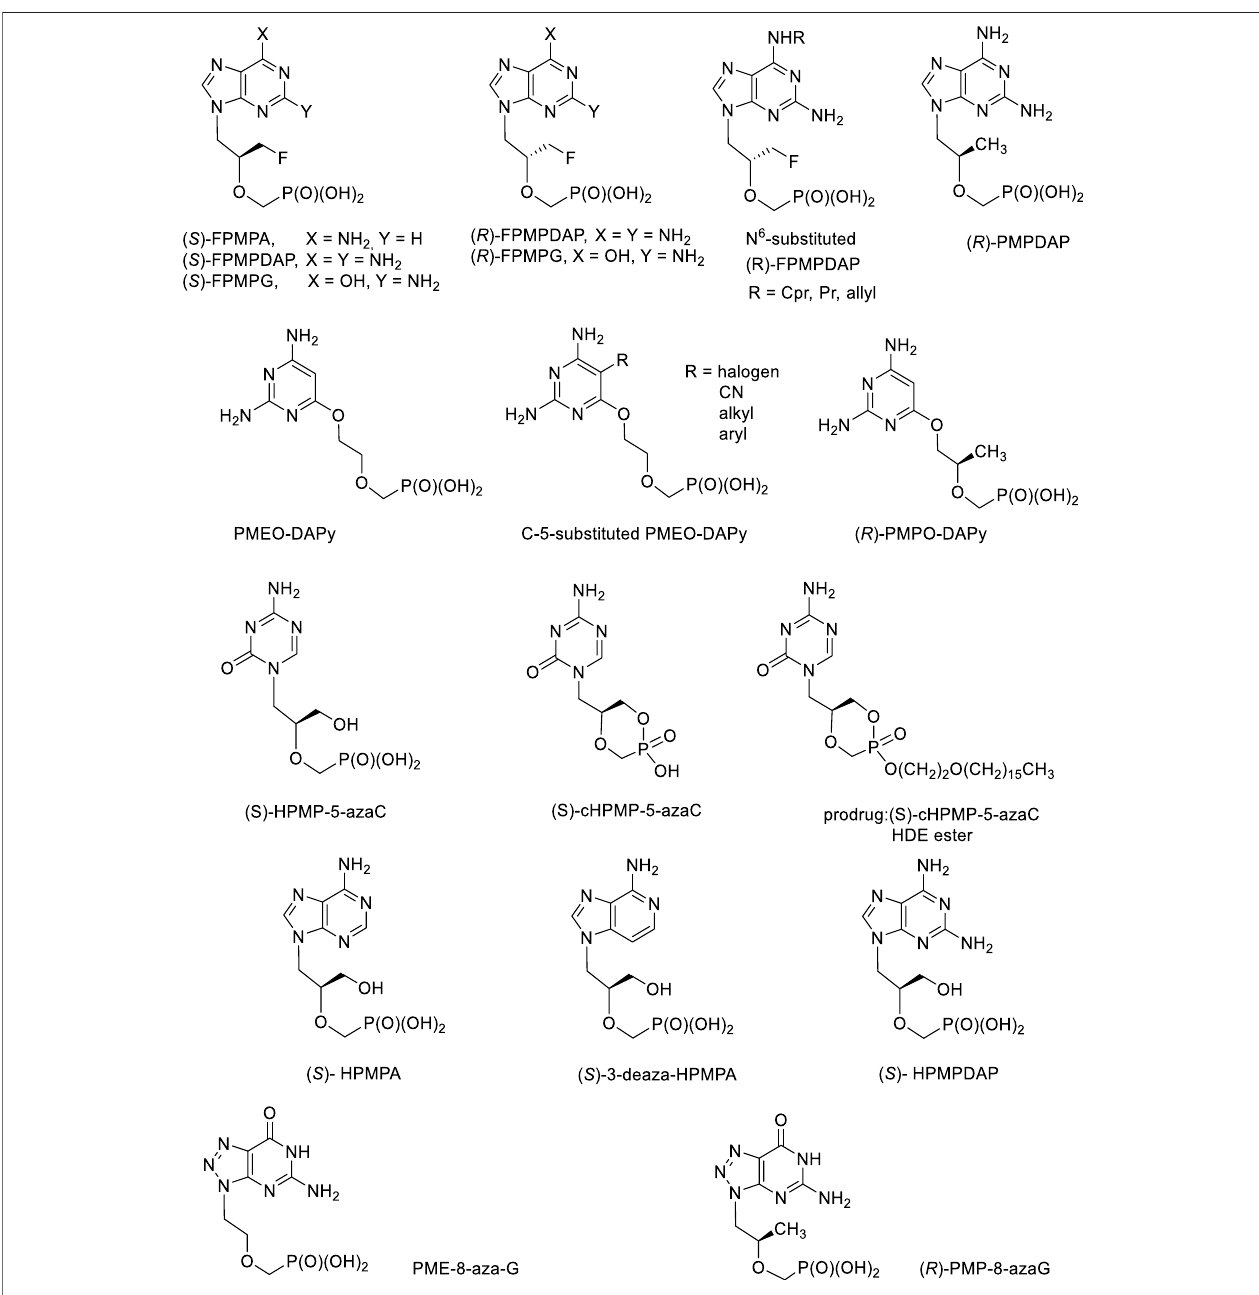
FIGURE 11 | Biologically active acyclic nucleoside phosphonates still waiting for their opportunity for further development.